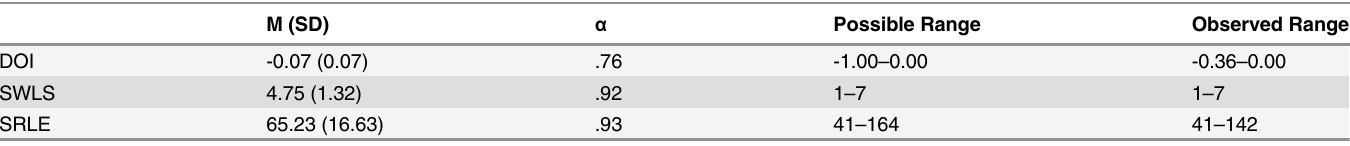
Table 1. Descriptive statistics — Study 1 ( N =